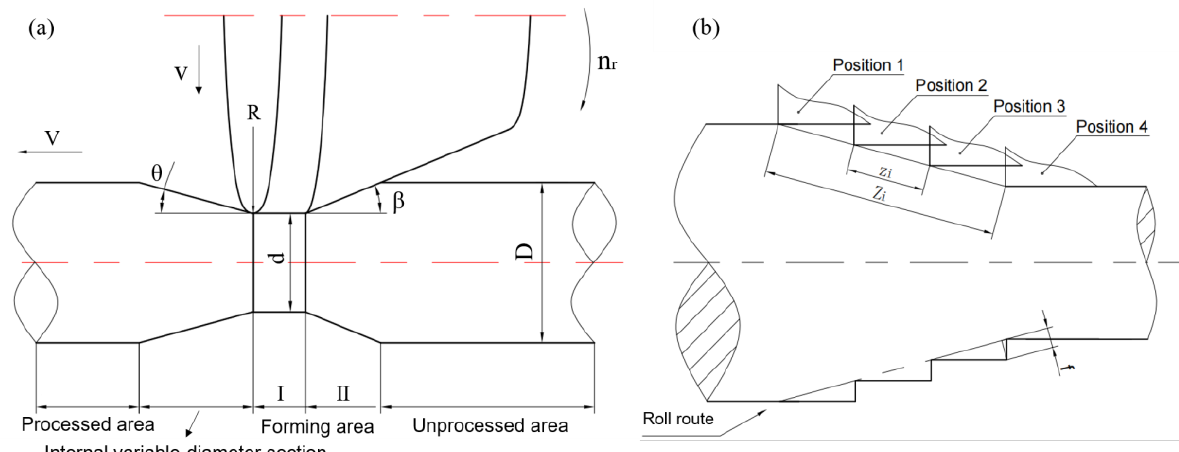
Figure 4. Simplified model of variable-diameter section.